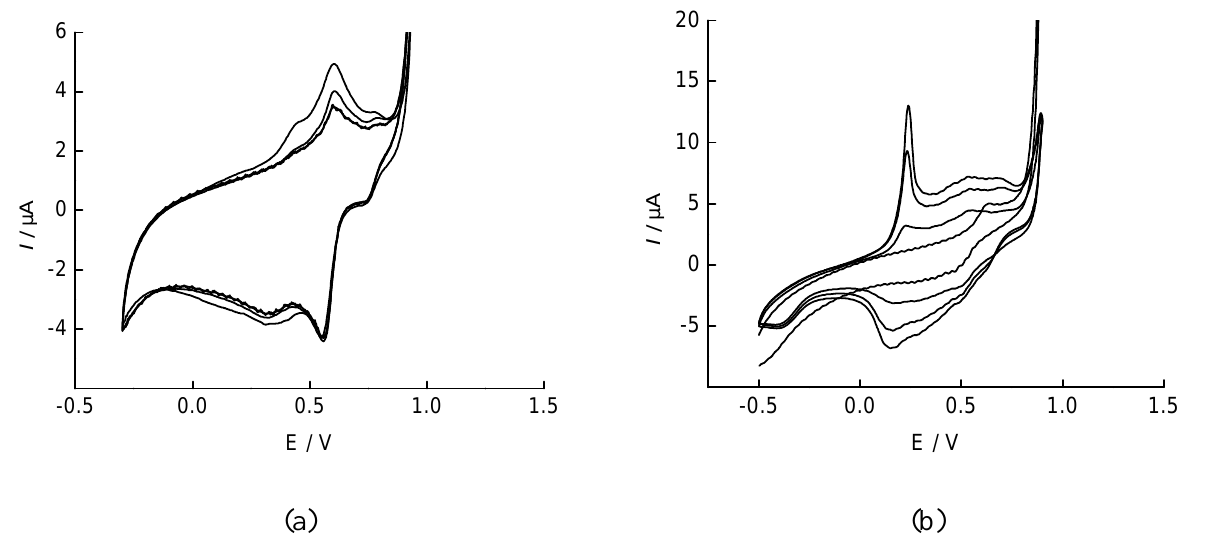
Figure 1. Cyclic voltammograms of polymer films formed on glassy carbon electrodes from: